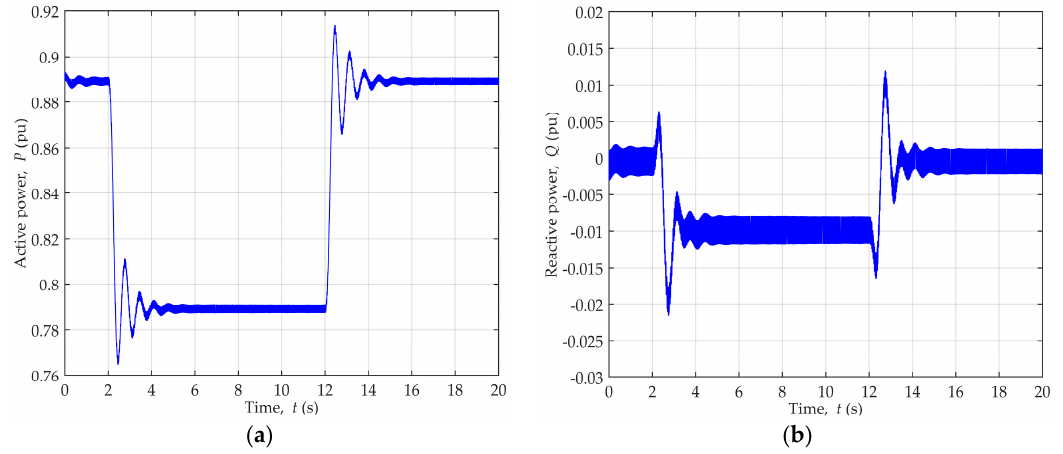
Figure 16. Generator power change during dynamic disturbances of active power for generator operating point P = 0.89, Q = 0: ( a ) Active power; ( b ) Reactive